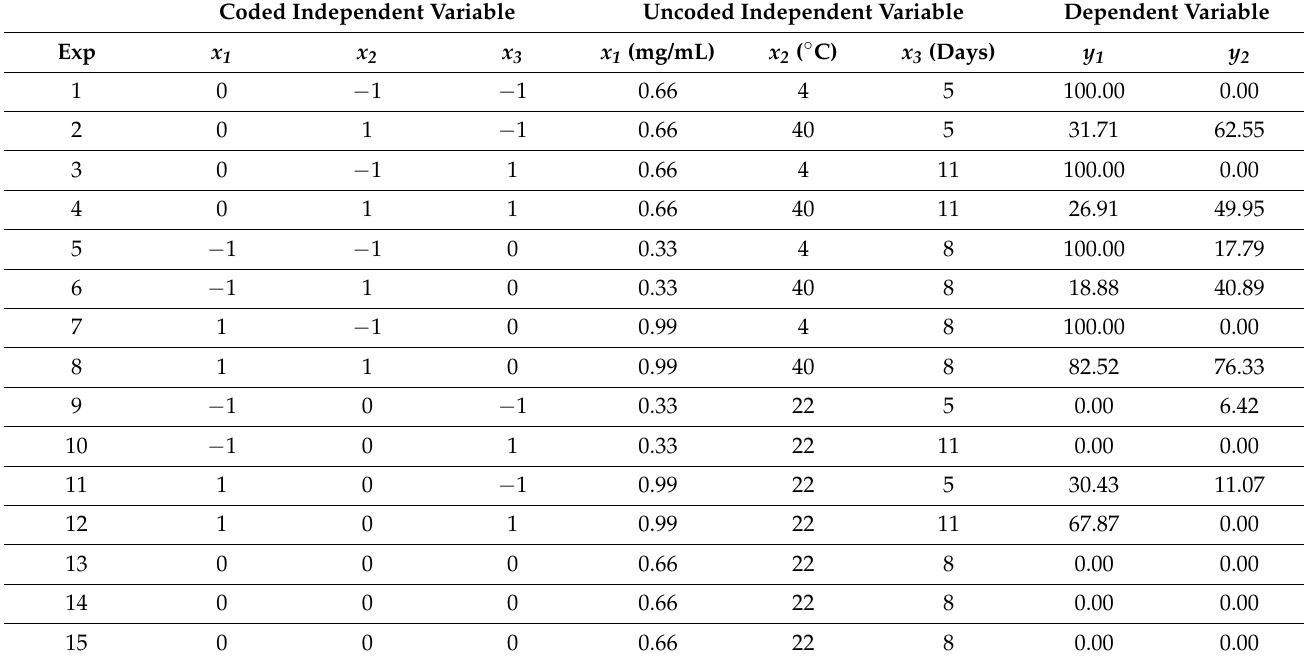
Table 2. Operational conditions used in this study, expressed as coded dimensionless and uncoded independent variables: concentration of the biosurfactant ( x 1 ), temperature ( x 2 ), and incubation time ( x 3 ); the results obtained for the dependent variables: y 1 (% of growth inhibition of A. brasiliensis ) and y 2 (% of growth inhibition of C. albicans ). ( − 1, minimum value of the variable within the range; 0, central value of the variable within the range; 1, maximum value of the variable within the range).